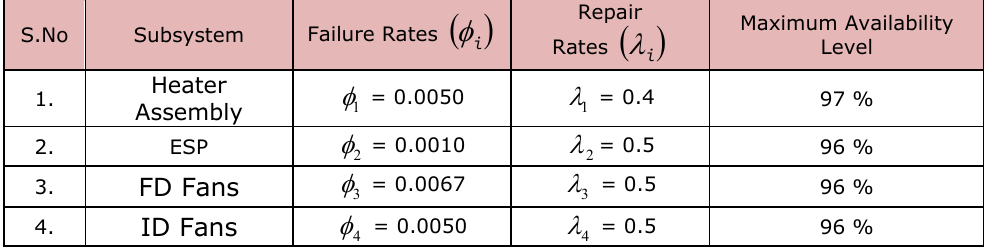
Table 5. “Optimum values of failure/repair rates of Subsystems of Fuel gas and air system”. Table 5 helps in identifying the subsystem with maximum availability. It is observed that first subsystem is having maximum availability (97%). The optimum values of failure and repair rates for maximum availability level for each subsystem is also shown in table